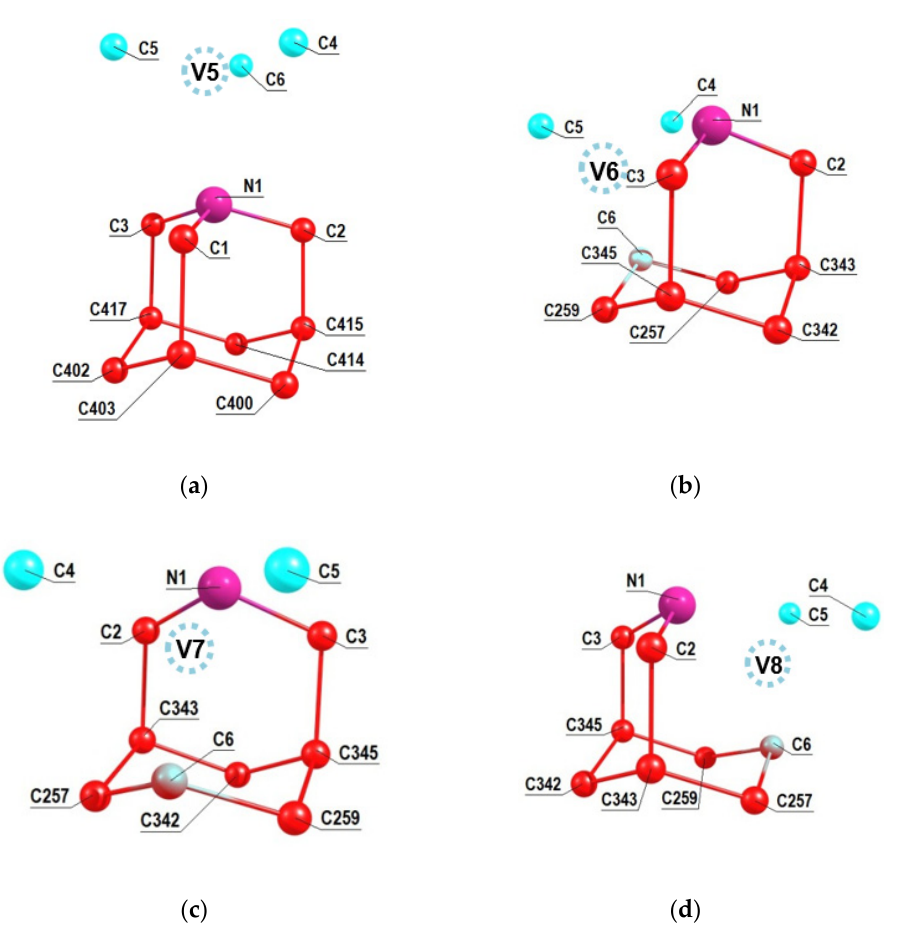
Figure 5. Numeration of carbon atoms in the 1-aza-adamantante seed in the C 510 [NV]-H 252 cluster at the NV5 ( a ), NV6 ( b ), NV7 ( c ) and NV8 ( d ) orientations of the NV center with respect to the seed.